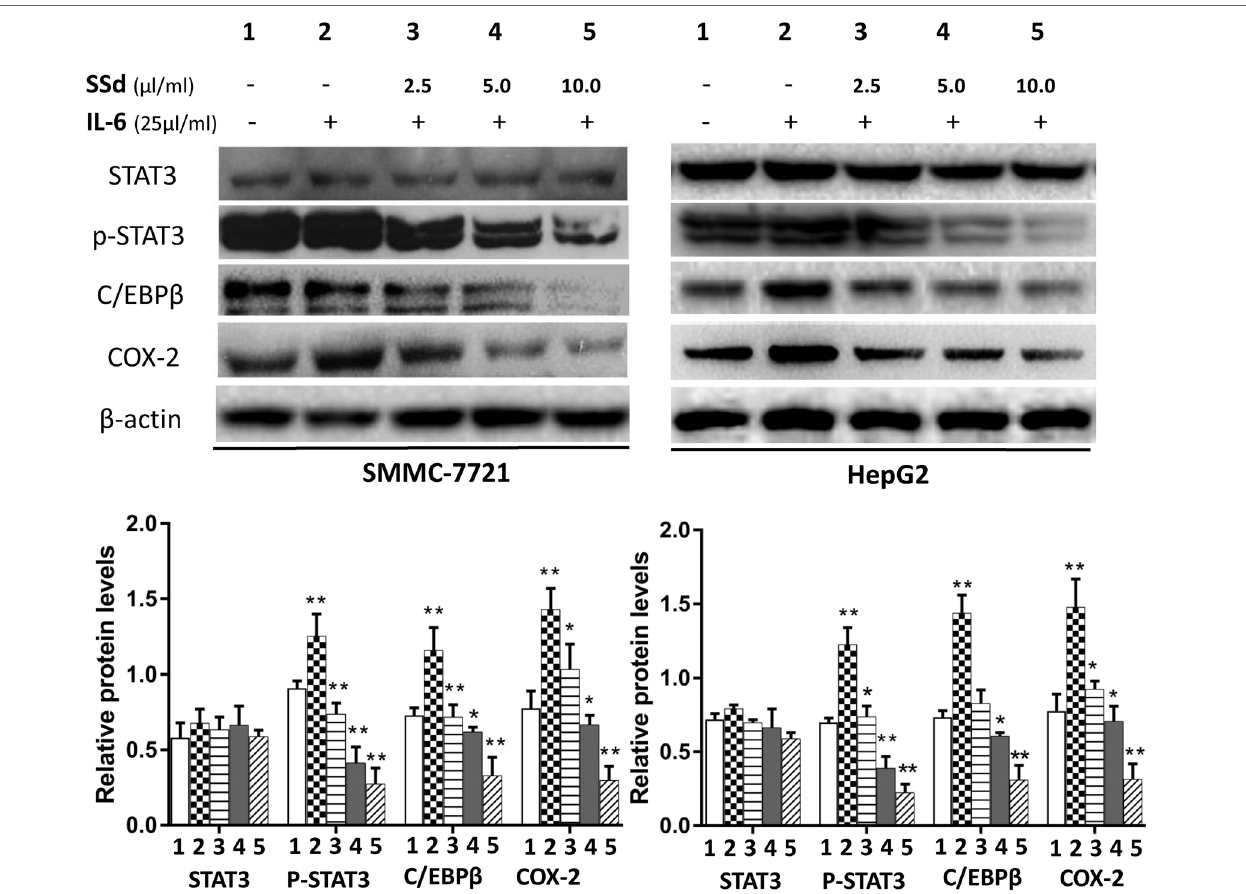
FIGURE 4 | Protein expression of total STAT3, p-STAT3, C/EBP β , and COX-2 following treatment with SSd. SMMC-7721 and HepG2 cells were seeded into six-well plates (2.5 × 10 5 /well). After 24-h culture in RPMI-1640 medium, the cells were divided into five groups and treated with SSd in the following conditions: 1) Control group cells received no drug treatment; 2) cells treated with IL-6 (25 ng/ml) only; 3) cells treated with IL-6 (25 ng/ml) + SSd (2.5 μg/ml); 4) cells treated with IL-6 (25 ng/ml) + SSd (5.0 μg/ml); 5) cells treated with IL-6 (25 ng/ml) + SSd (10.0 μg/ml). Representative Western blot of results are shown in upper panels. For the quantitation of Western blots, protein expression was normalized to β -actin levels in each lane and expressed relative to levels in normal cells. The data are presented as the mean ± SD of three separate experiments. * P < 0.05 and ** P < 0.01 when compared with group 2, where cells were treated with IL-6